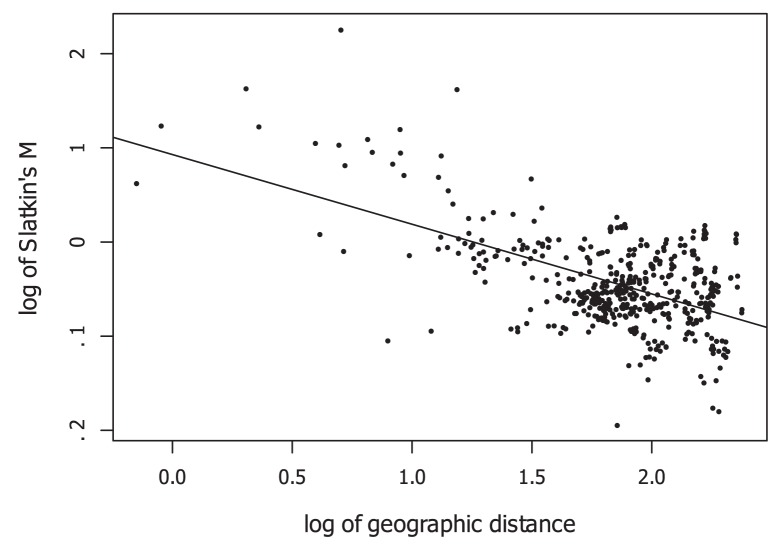
Log10 () plotted against log10(geographic distance in km) for the threatened riparian shrub Myricaria germanica based on samples from 31 sites in Switzerland.The linear regression equation used to plot the line was log10() = 0.93−0.74×log10(geographic distance), with an adjusted R
2 of 0.314.